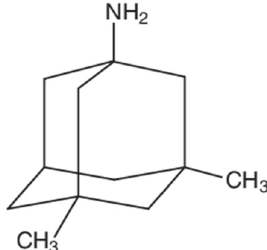
Figure 4. Chemical Structure of Memantine.